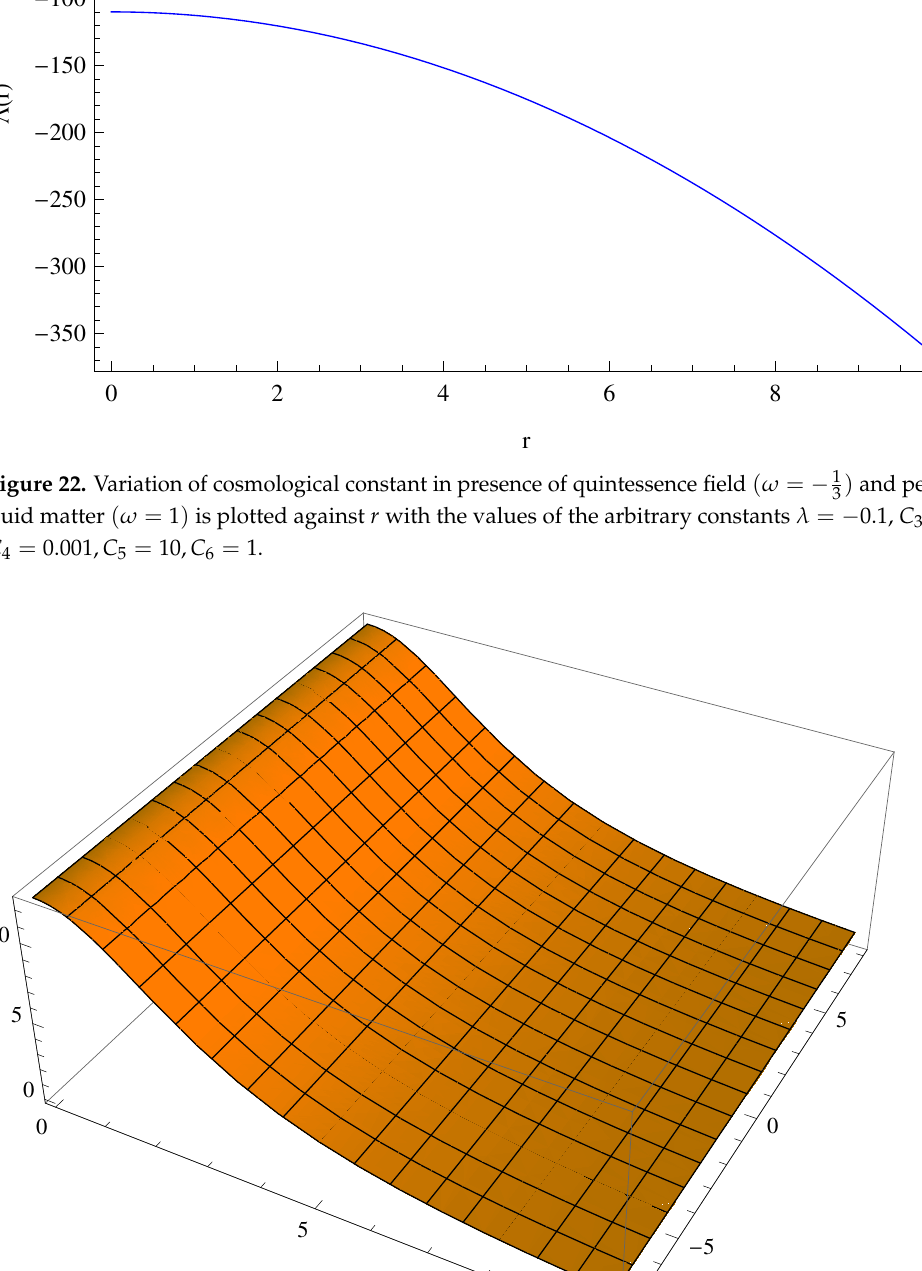
Figure 23. Variation of cosmological constant in presence of perfect fluid matter ( ω = 1 ) is plotted against r with the values of the arbitrary constants λ = 0.1, C 3 = 2, C 4 = 0.001, C 5 = 10, C 6 =